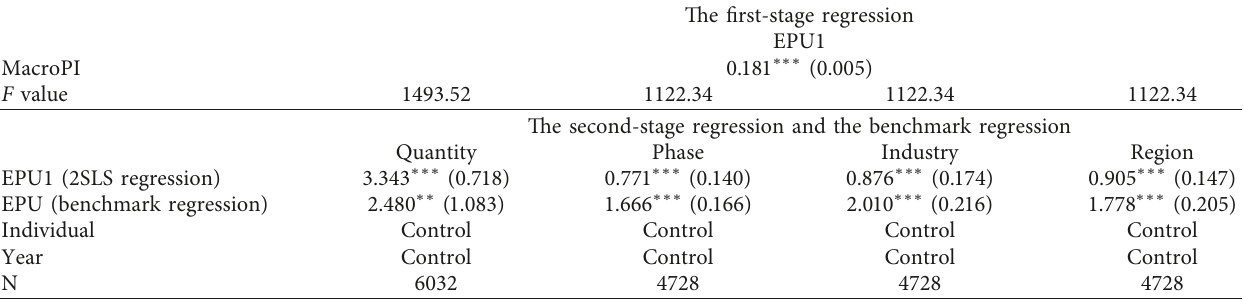
Table 5: Comparison between the estimation results of the instrumental variable in two-stage least squares (2SLS) and the benchmark results.